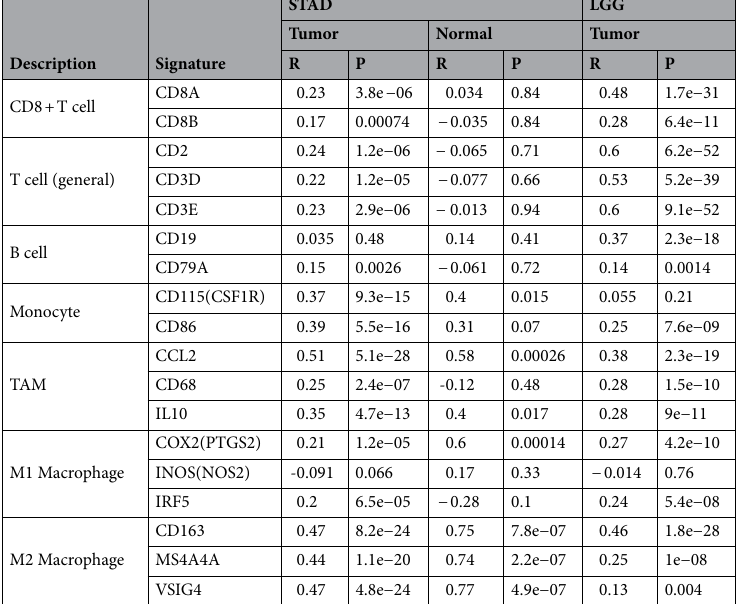
Table 2. The correlations between TIMP1 expression and immune marker sets in